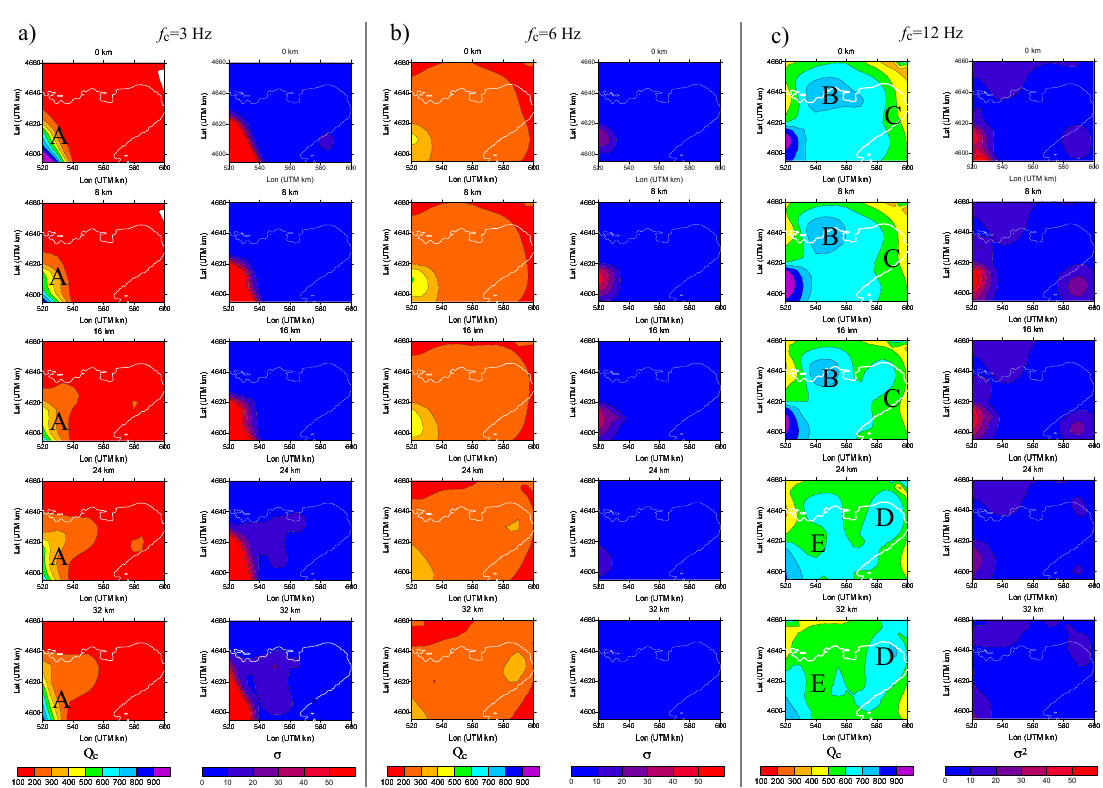
Figure 8. Section maps of Q c and σ at various depths for t L = 30 s: ( a ) f c = 3 Hz; ( b ) f c = 6 Hz; ( c ) f c = 12 Hz. The coastline is in white. Labels A, B, C, D and E refer to the Q c anomalies commented in the discussion section.